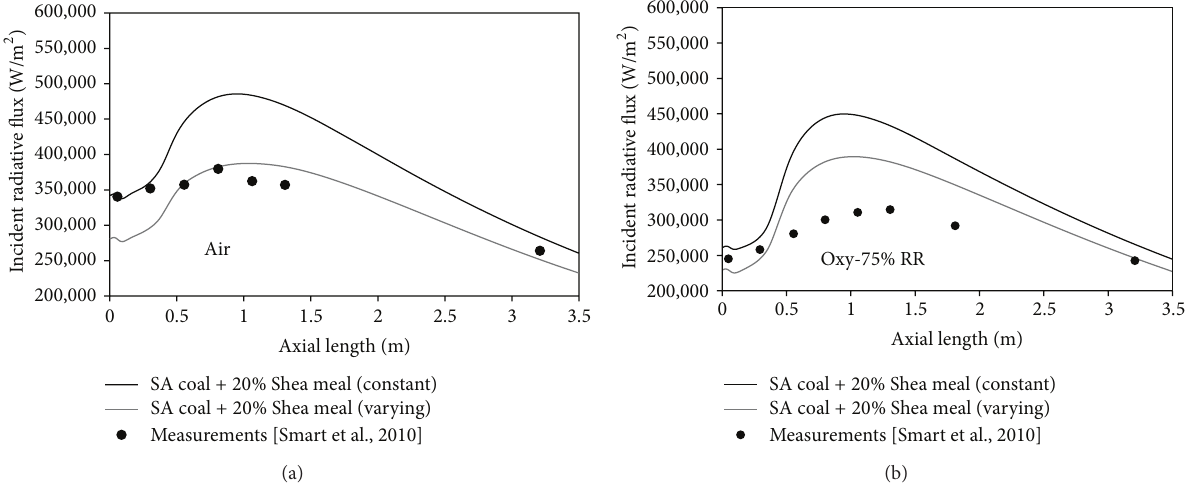
Figure 10: Wall incident radiative flux profiles predicted during the co-combustion of SA coal and biomass particles in air and oxy-75%